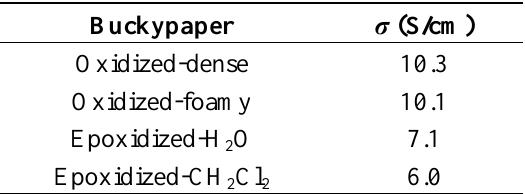
Table 3. DC electrical conductivity of the